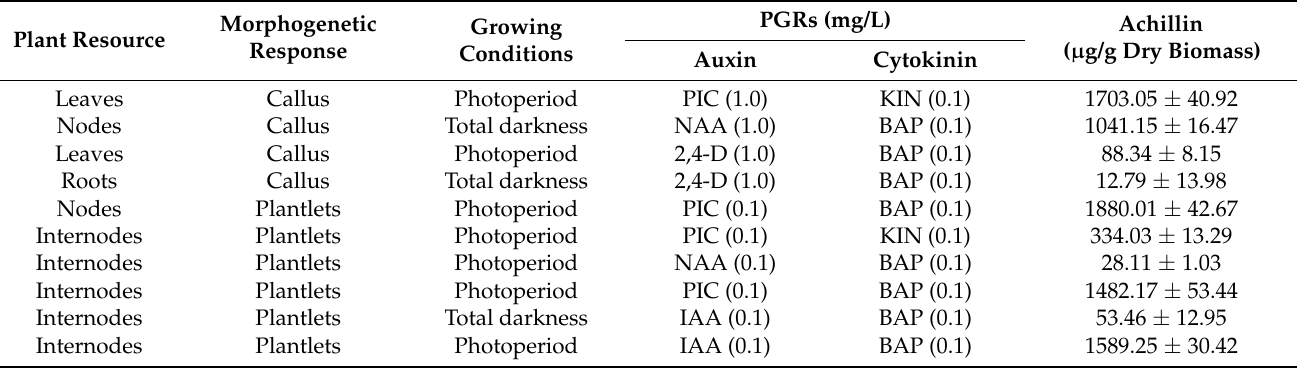
Table 4. Achillin content in the biomass of different morphogenetic responses (callus and plantlets) of A. ludoviciana analyzed by